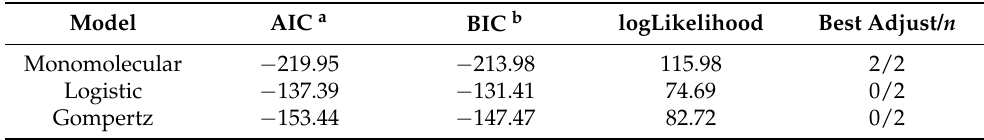
Figure 2. Incidence of Fusarium wilt of bananas in plots with ( a ) and without ( b ) management of weevil borer ( Cosmopolites sordidus , WB) from April 2017 to February 2019 (points). Monomolecular model adjusted to incidence data (curves) Estimated initial incidence ( y 0 ), progress rate ( r ) of epidemics, and the measure of the quality of the adjusted monomolecular model ( R 2 ) are presented. Table 2. Summary of statistics used to evaluate the disease progress curve of Fusarium wilt of banana in two plots, with and without weevil borer management, located in the municipality of Teixeiras, Minas Gerais state, Brazil, from April 2017 to February 2019.